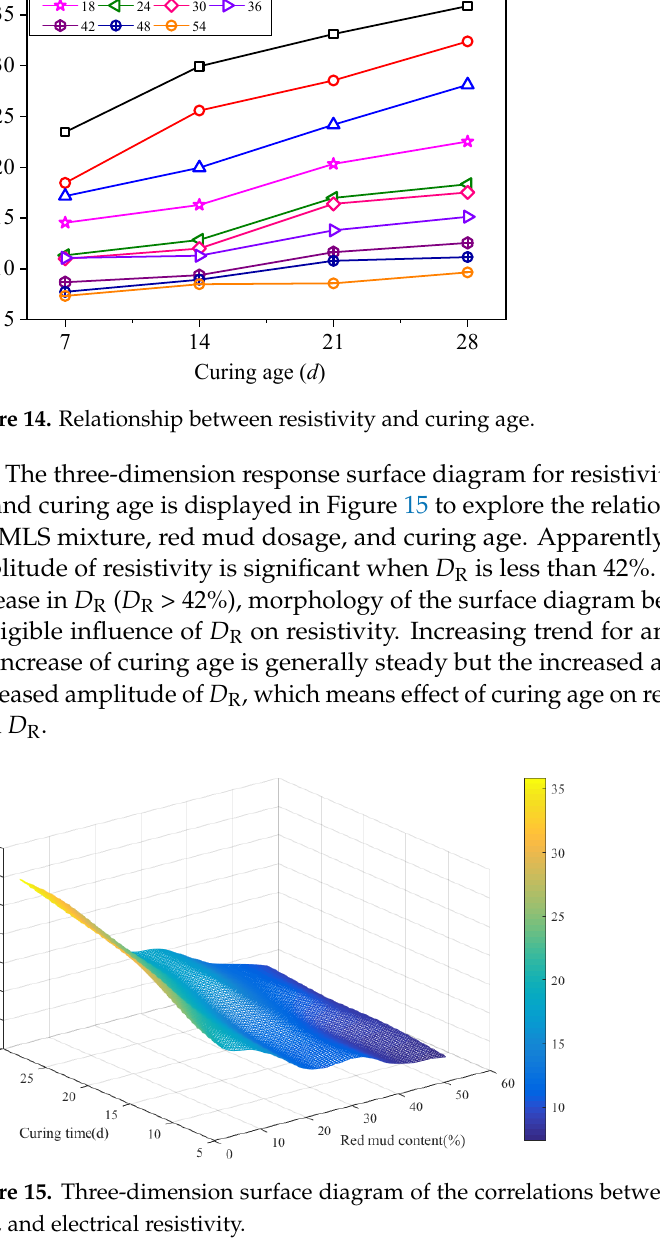
Figure 13. Relationship between resistivity and red mud dosage.